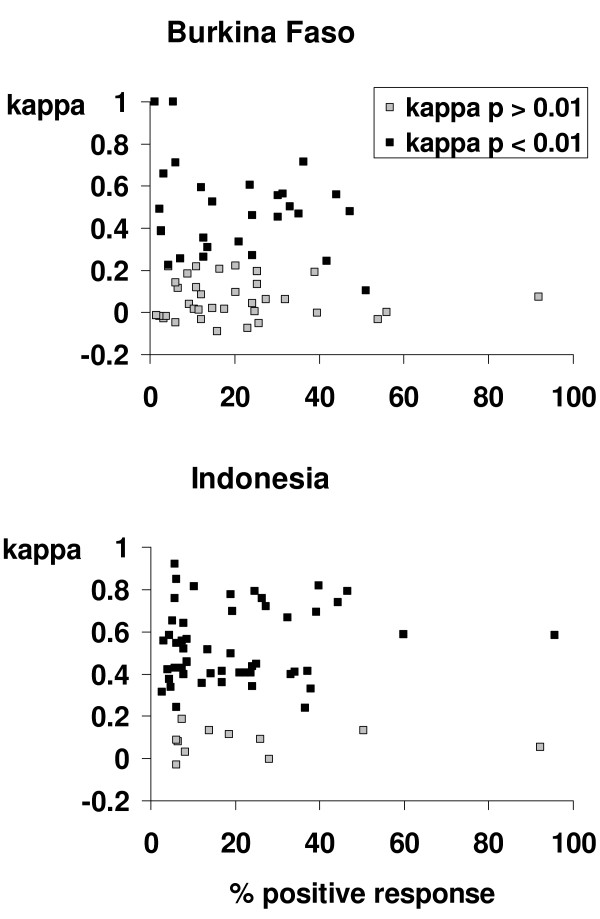
Distribution of kappa statistics versus positive response rate for indicators obtained from repeated verbal autopsy interviews in Burkina Faso (n = 91) and Indonesia (n = 116).